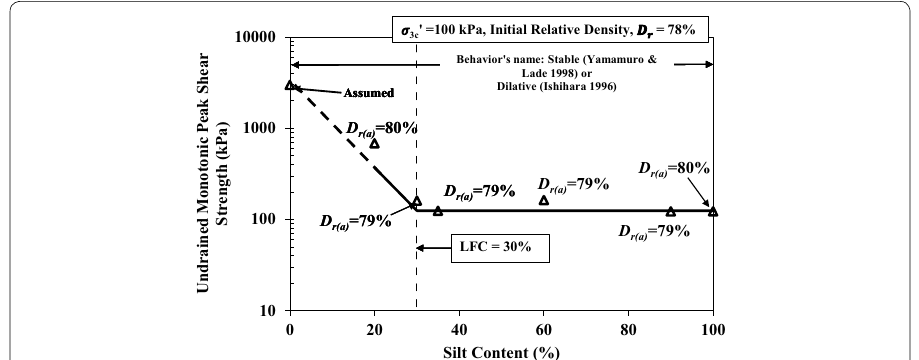
Fig. 22 Effect of silt content on undrained monotonic peak shear strength of sand–silt mixture at Canstant relative density of 78%